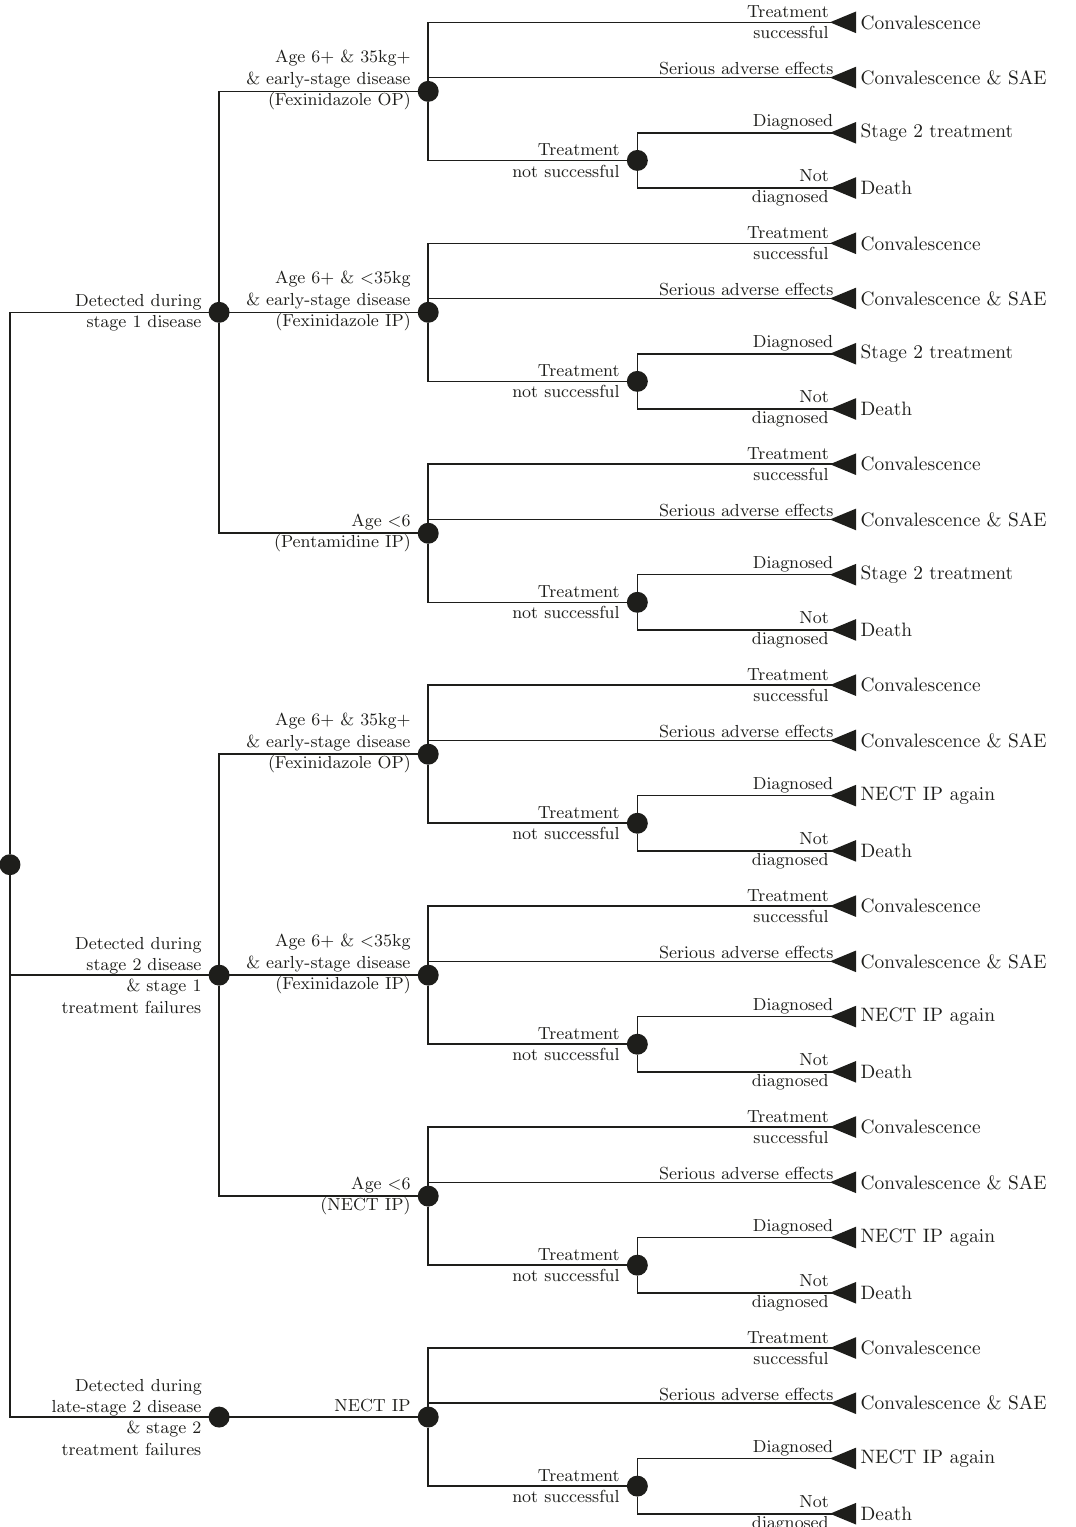
Fig. 2 Treatment for diagnosed gHAT patients is modeled as a branching tree process of possible health outcomes including eligibility for novel treatment fexinidazole. Stage 2 disease treatment sometimes applies to stage 1 treatment failures, and some late-stage disease includes some patients who were stage 2 treatment failures. The outcomes of the small proportion of cases that experience unsuccessful treatment are determined by calculating the product of the probability of unsuccessful treatment and the outcome of disease at a later stage of disease. Cases are assumed to go through treatment at most twice. Abbreviations: SAE serious adverse events, IP inpatient care, OP outpatient care, NECT nifurtimox-e fl ornithine combination